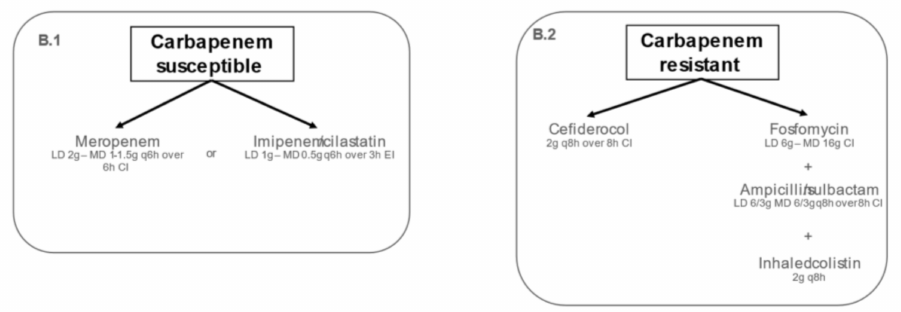
Figure 2. Algorithms for targeted treatment of IVAC caused by full-susceptible and multidrug- resistant Acinetobacter baumannii . CI: continuous infusion; EI: extended infusion; LD: loading dose; MD: maintenance dose; MDR: multidrug